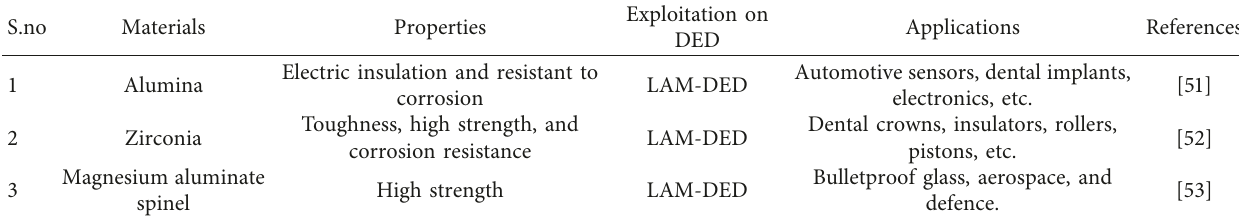
Table 6: Types of feed materials